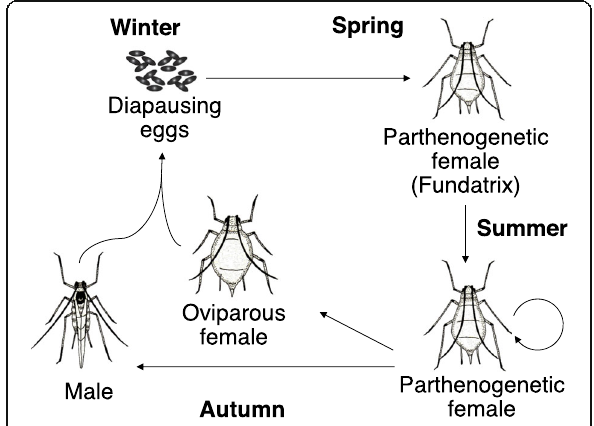
Fig. 1 Cyclic parthenogenesis in the pea aphid. Oviparous sexual females appear only once per year, while parthenogenetic females occur throughout the rest of the annual life